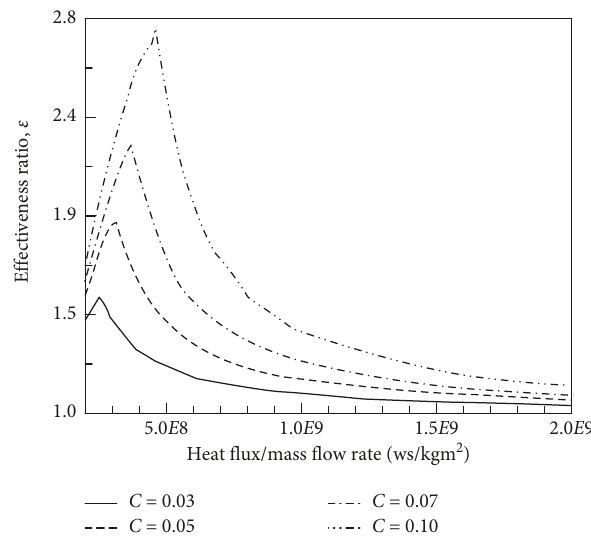
Figure 5: Effect of heat flux per unit mass flow rate on the effec- tiveness ratio for various concentrations of lauric acid slurry